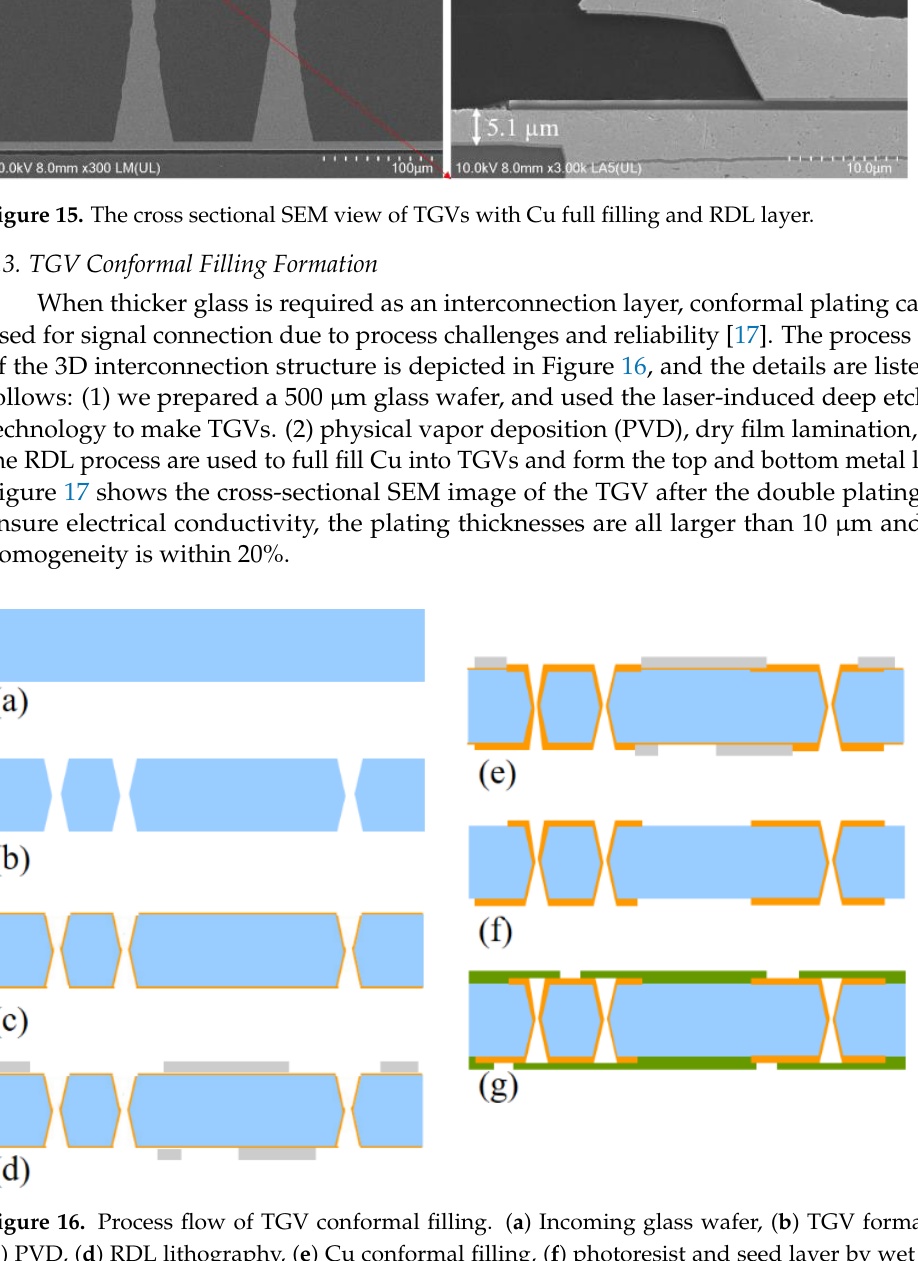
Figure 15. The cross sectional SEM view of TGVs with Cu full filling and RDL layer.